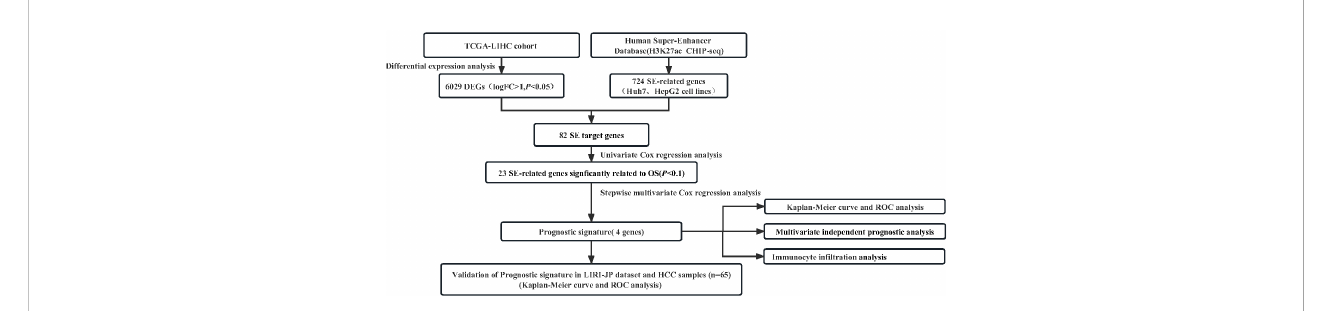
FIGURE 2 Flowchart presenting the process of establishing the SE − gene − based prognostic signature of HCC in this study.